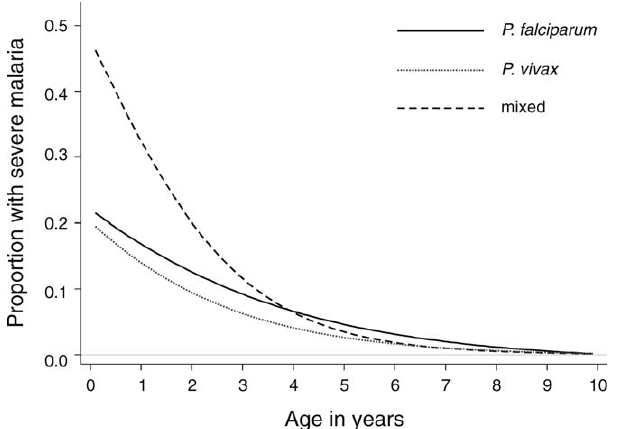
Figure 2. Age-Specific Risk of Severe Disease with P. falciparum , P. vivax , and Mixed Infections in Children , 10 y